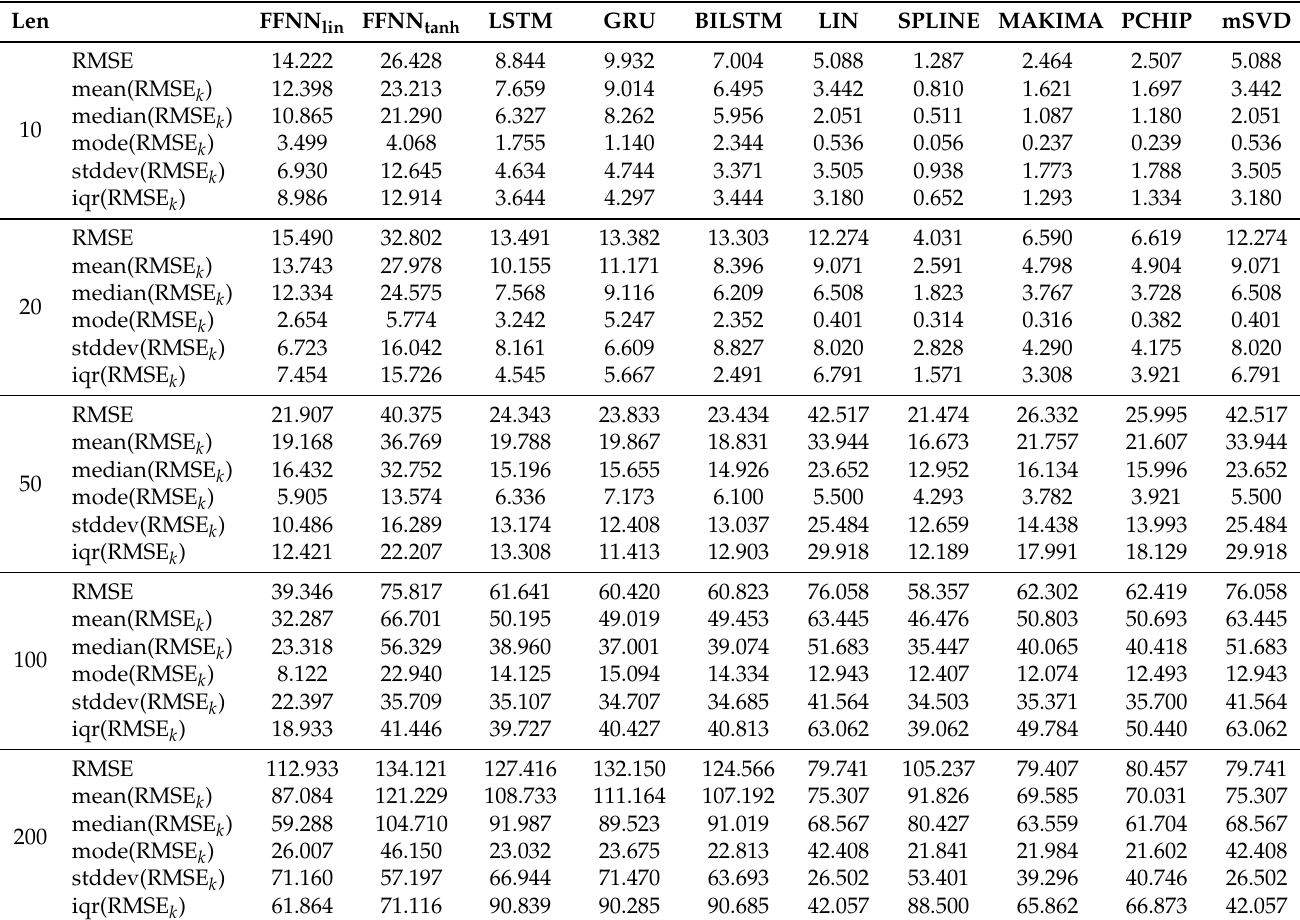
Table A1. Quality measures for the walking (No. 2) sequence.